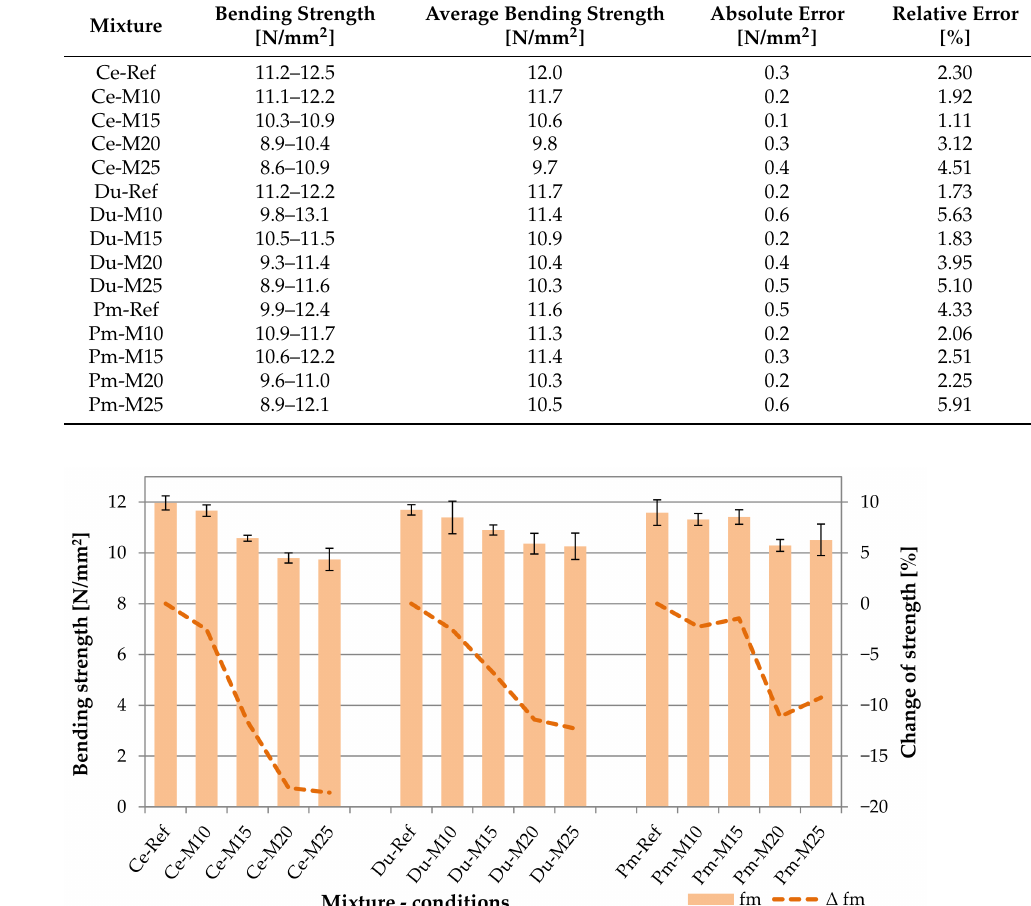
Figure 13. Comparison of bending strength; columns—bending strength (f m ), curves—change of bending strength ( ∆ f m